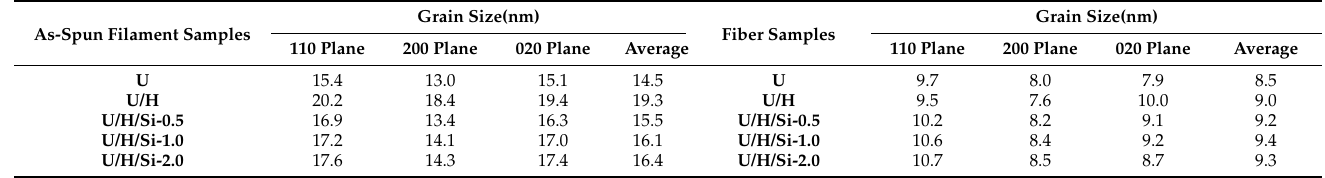
Table 3. Grain sizes of all as-spun filament and fiber samples.